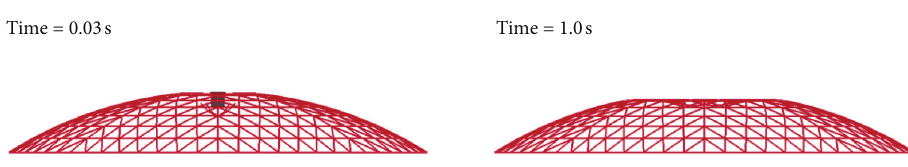
Figure 6: Damage process of the impact event with impactor of 2m diameter and 10T mass and the striking velocity of 100m/s.